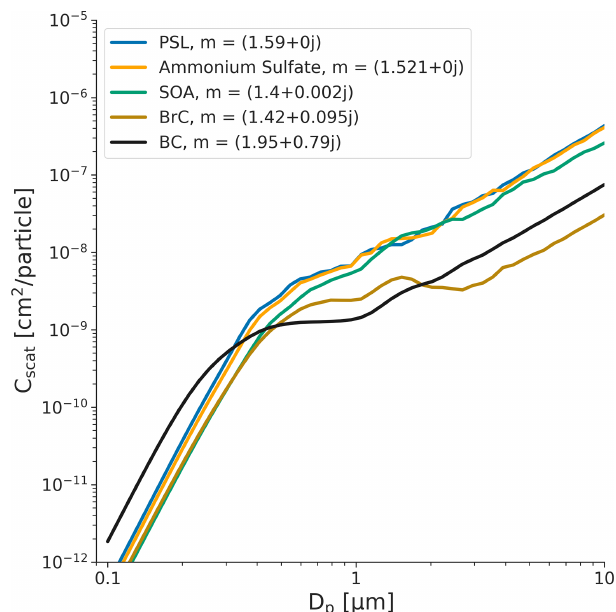
Figure 3. Mie curves (integrated over a viewing angle of 32–88 ◦ ) for a select group of common calibration materials. Materials shown include polystyrene latex spheres (PSLs), ammonium sulfate, sec- ondary organic aerosol (SOA), and black carbon (BC). Small dif- ferences in the refractive index of a measured material can lead to drastic bin misassignment depending on where bin boundaries are set at the time of calibration.